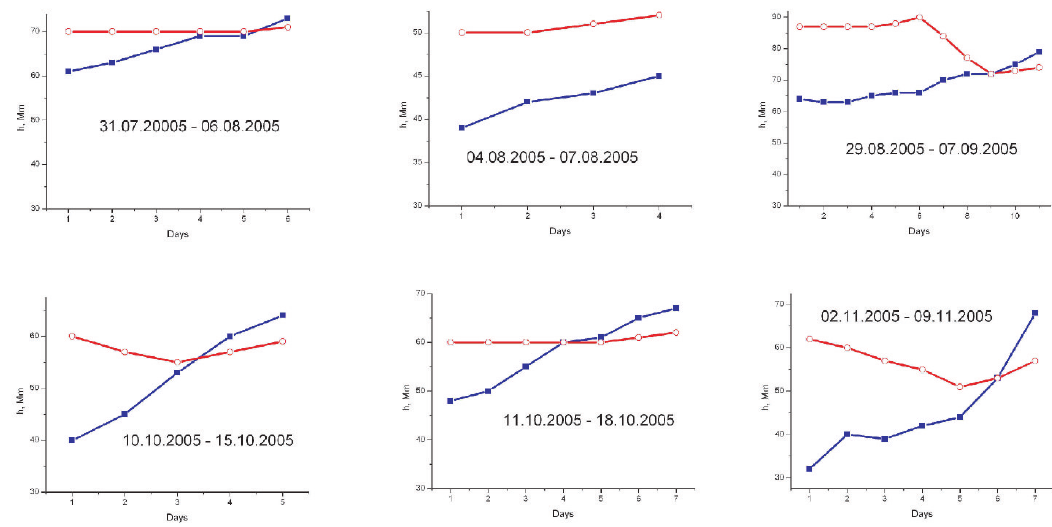
Fig. 8. Temporal behaviour of the filament height h p (blue squares) above the photosphere and the critical height h c (open red circles) several days before eruption in the latter part of